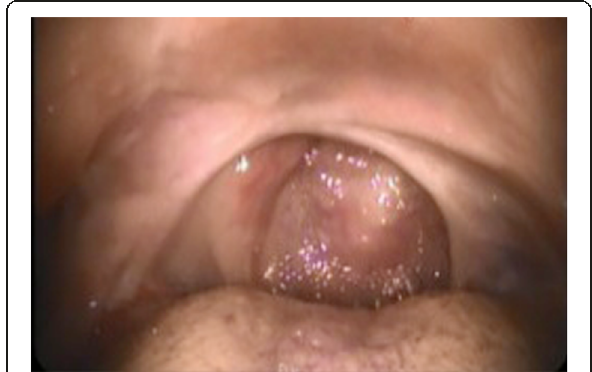
Fig. 3 Laryngofiberscopic view beyond the cicatrix. The supraglottic space and the vestibule are